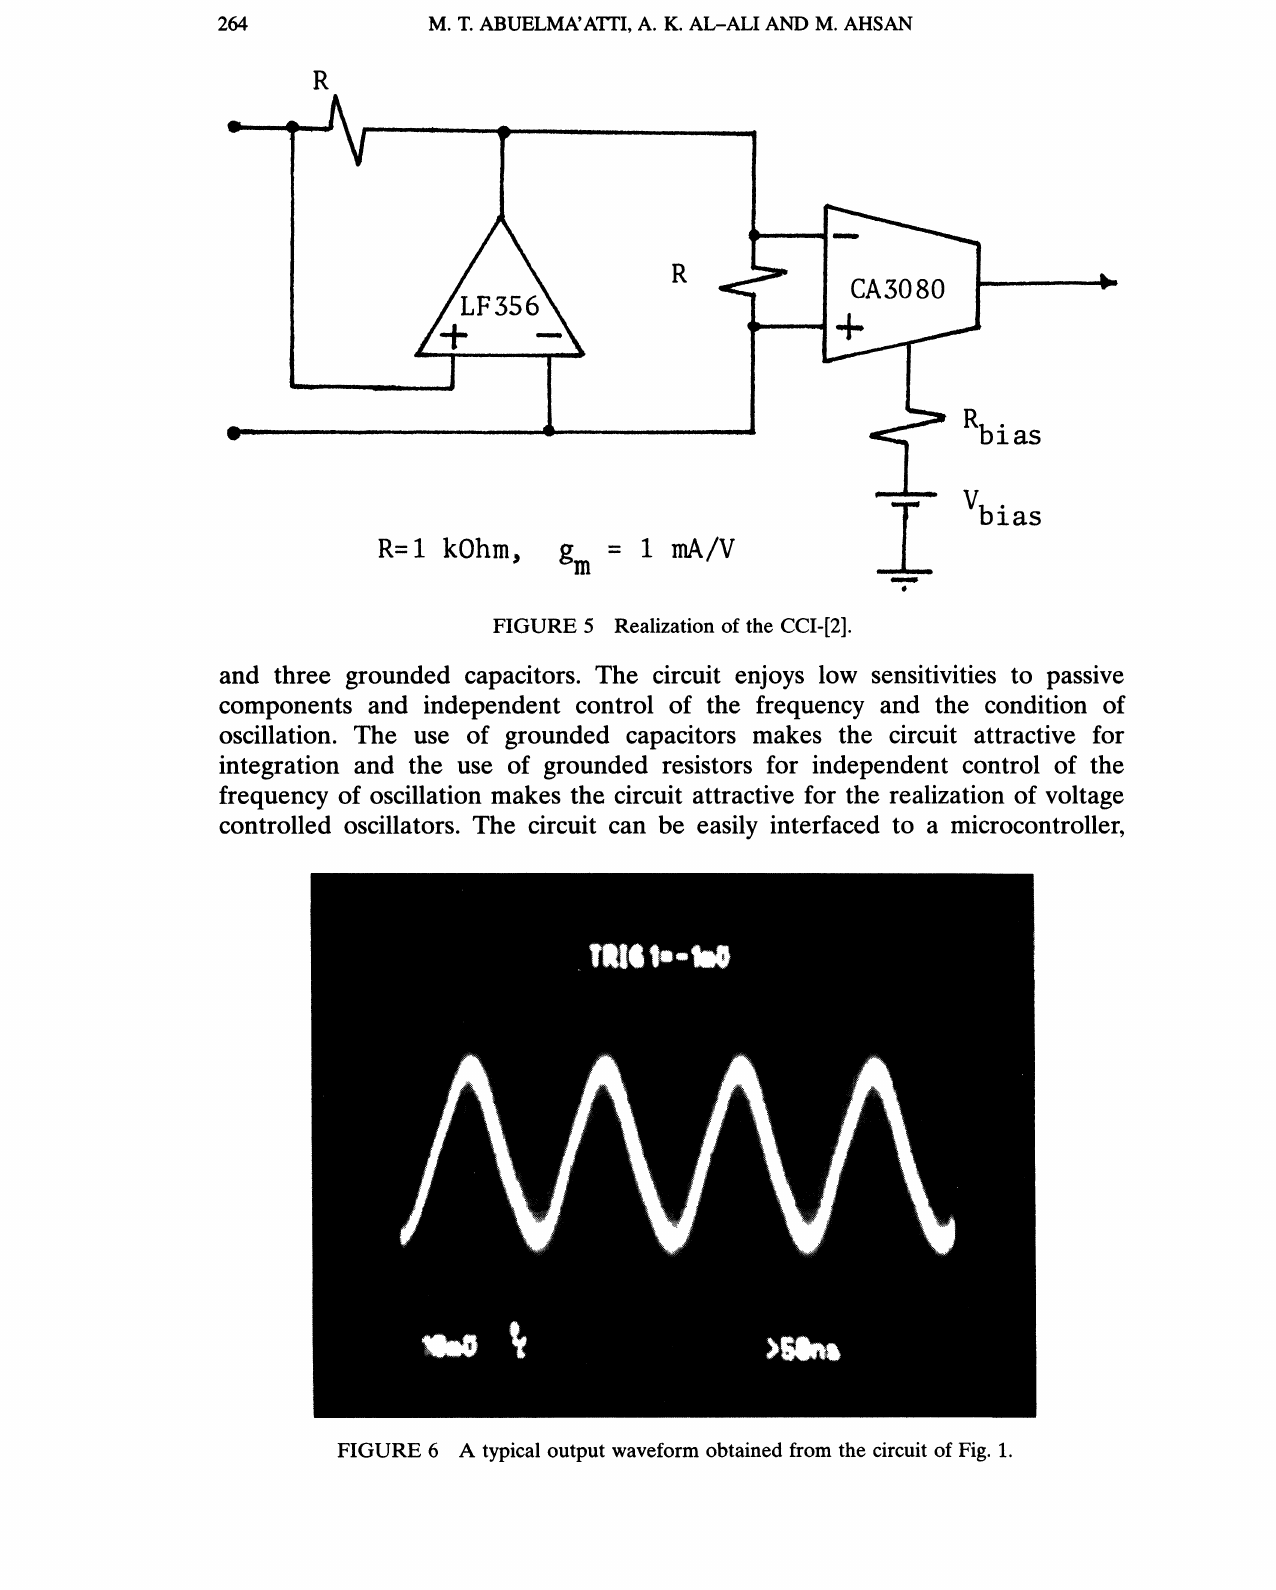
FIGURE 6 A typical output waveform obtained from the circuit of Fig.